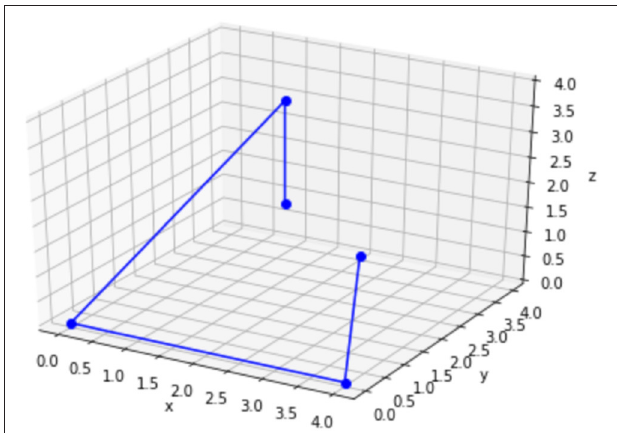
FIGURE 4 | Tetrahedron in three